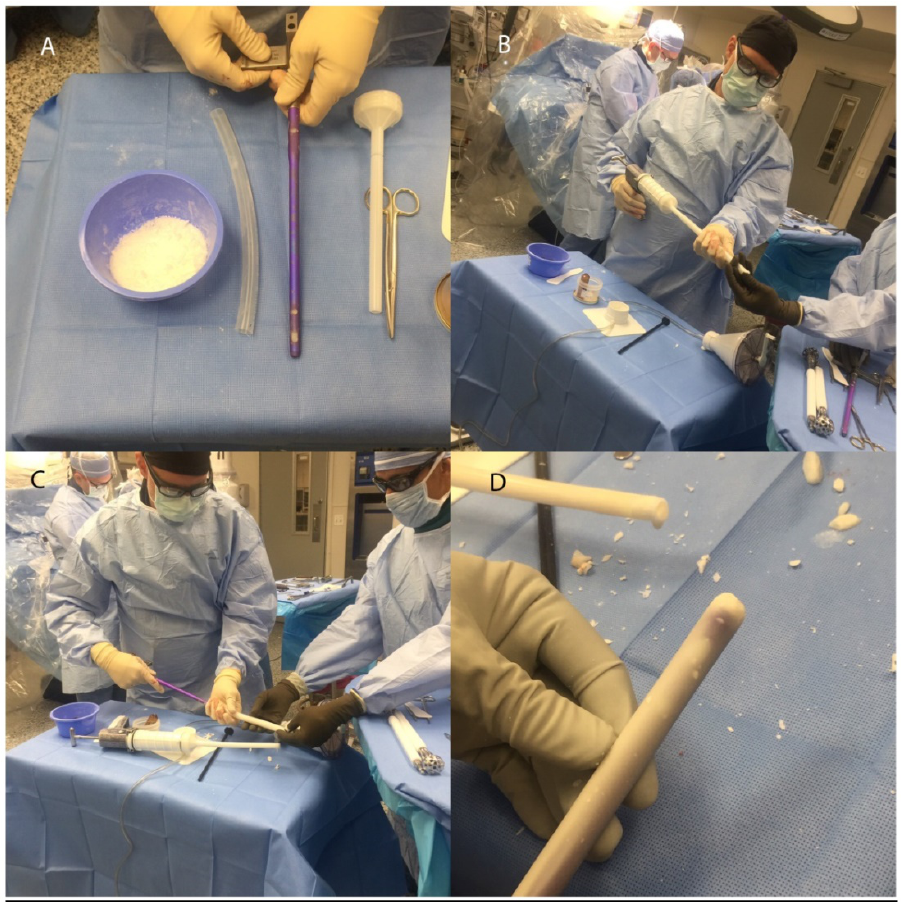
Figure 1 . Photographs demonstrating the technique of coating intramedullary nails with antibiotic cement. (A) The nail is assembled, bone wax is placed into the holes, and the silicon tubing is cut to length. (B) The antibiotic is mixed into the cement (often requiring more liquid monomer), and mixture is pumped into a silicone tube using a cement gun. (C) The nail is then inserted into the silicone tube while the cement is still wet. An assistant plugs the distal end of the tube to avoid excessive cement leakage and maximize the cement volume around the nail. (D) Once the cement is hardened, the mold is then removed, and the nail tip is fashioned into a bullet shape making it ready to insert. We typically over ream the canal by 2 mm more than the outer cement coating diameter. This would prevent delamination of the cement mantle when the nail is pushed into the canal.